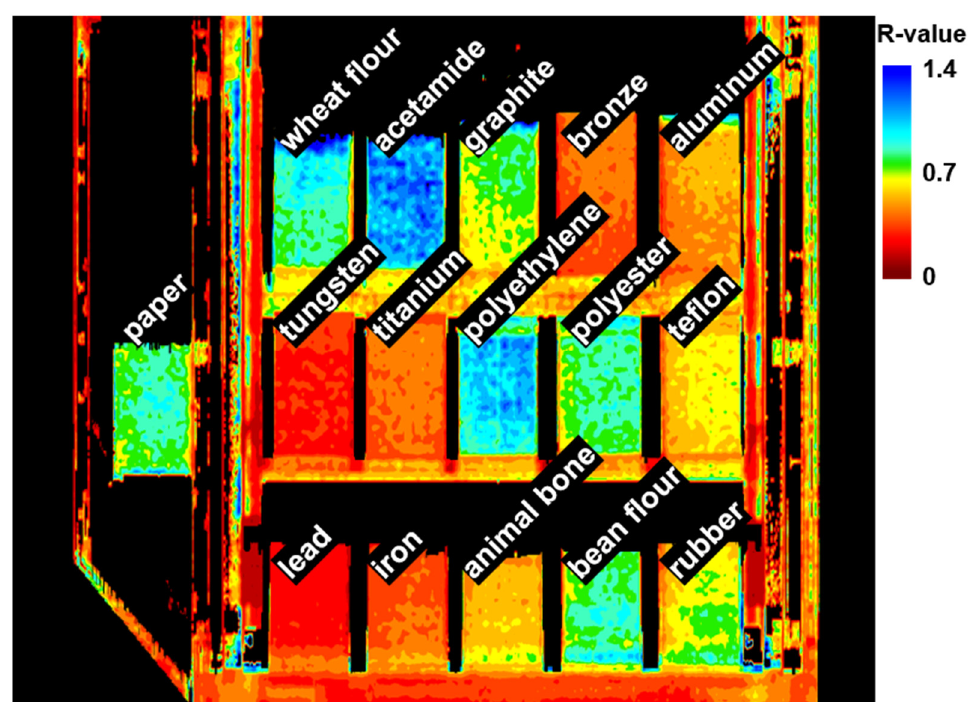
Figure 9. R-value image for an air cargo container with material samples.